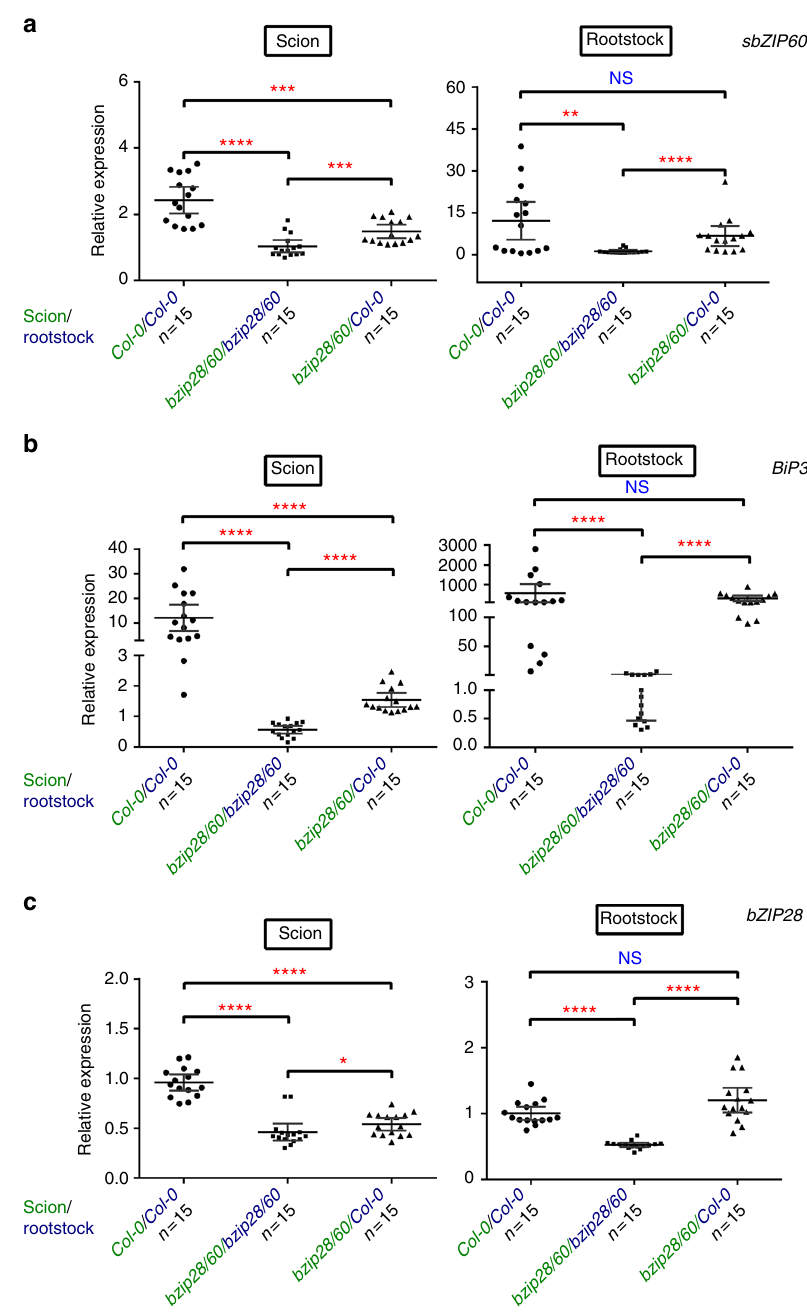
Fig. 4 Micro-grafting analyses support the existence of endogenous systemic UPR signals. a – c Plots of the mean values (dots) of the quantitative RT-PCR analyses of the transcripts of sbZIP60 ( a ) BiP3 ( b ) and bZIP28 ( c ) in scion and rootstock of 4-week-old grafted seedlings of wild-type and bzip28/60 backgrounds treated with DMSO or 0.5 μ M Tm (Tunicamycin) for 48 h as described in Fig. 3a. The average of all the values is indicated by a black line. Error bars represent mean with 95% con fi dence interval among all grafts. Error bars above and below indicate the 95th and 5th percentiles. Average values signi fi cantly different from the values of wild-type (Col-0) and bzip28/60 self-grafts are indicated by red asterisks (* P < 0.05, ** P < 0.01, *** P < 0.001,**** P < 0.0001, NS, nonsigni fi cant; Mann-Whitney test). n , total number of grafted